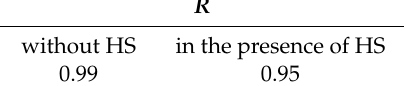
Table 1. Correlation coe ffi cients R between the bacterial bioluminescence yields and ROS contents in the bacterial suspensions. R without HS in the presence of HS 0.99